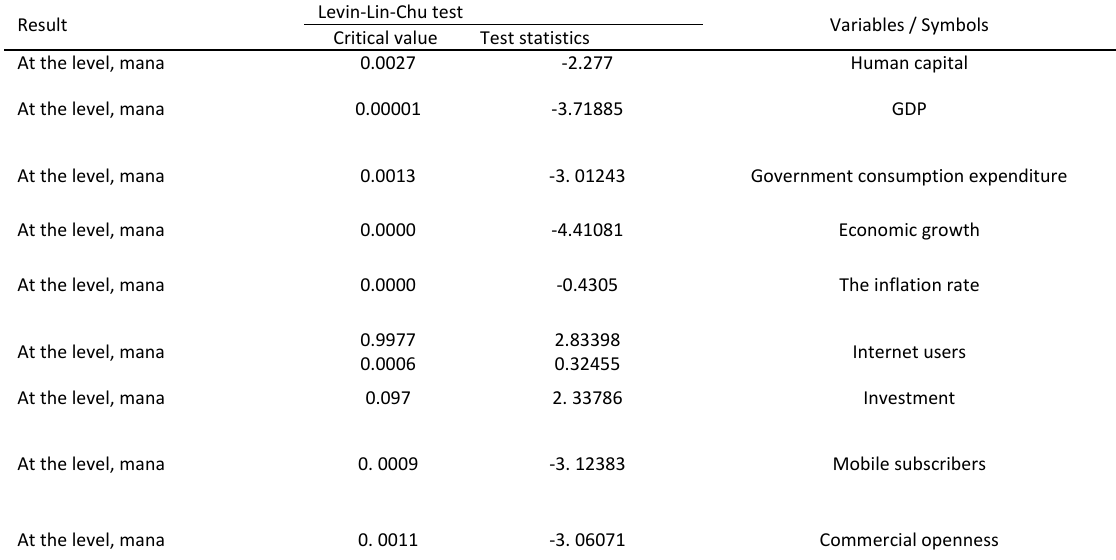
Table 1: The reliability test